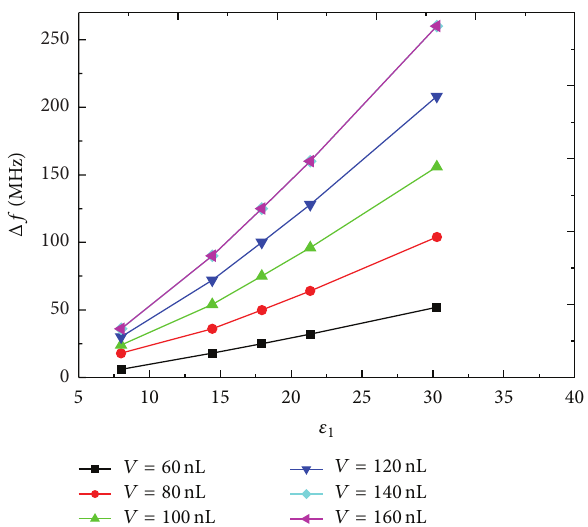
Figure 4: Variation of cancellation frequency with permittivity of LUT calculated by the proposed